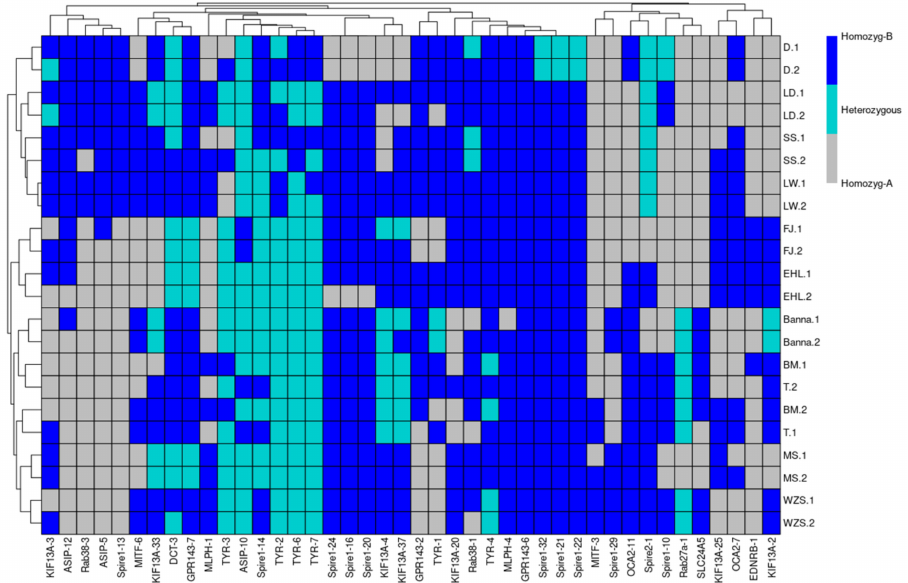
Figure 2. The pool-PCR results shown by heatmap. D (Duroc), LD (Landrace), LW (LargeWhite), SS (SuShan), EHL (Erhualian), FJ (Fengjing), Banna (Banna), BM (Bama), T (Tibetan), MS (Meishan), and WZS